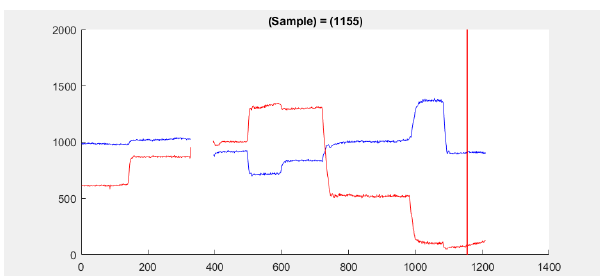
Figure 19 . Position plot for dataset 2.5 shows a drift beginning at sample 1155 (red